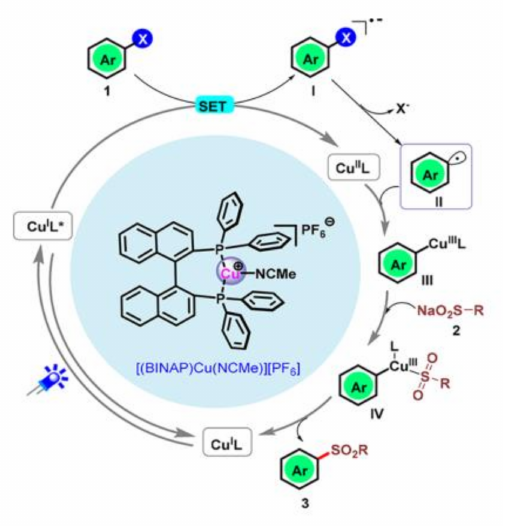
Figure 5. The mechanism of visible-light-driven aryl halides reduction with [(BINAP)Cu(NCMe)]PF 6 ] as photosensitizer. Reprinted with permission from Ref. [30]. Copyright 2021, American Chemical Society.